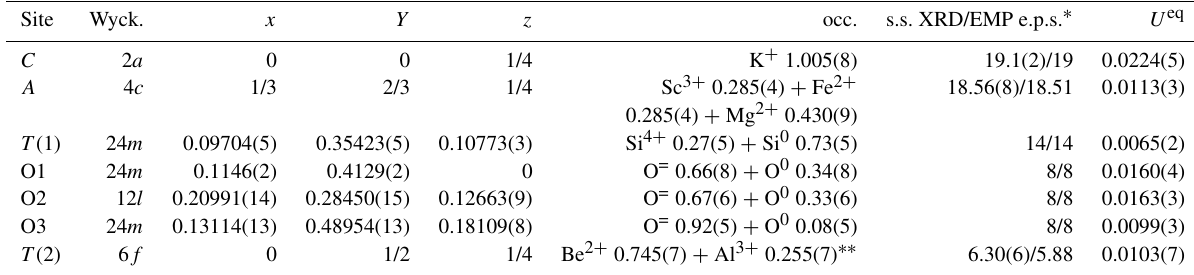
Table 7. Atomic coordinates, chemical site occupancies (occ.), electrons per site and isotropic displacement parameters U eq for laurentthom- asite. Wyck. stands for Wyckoff